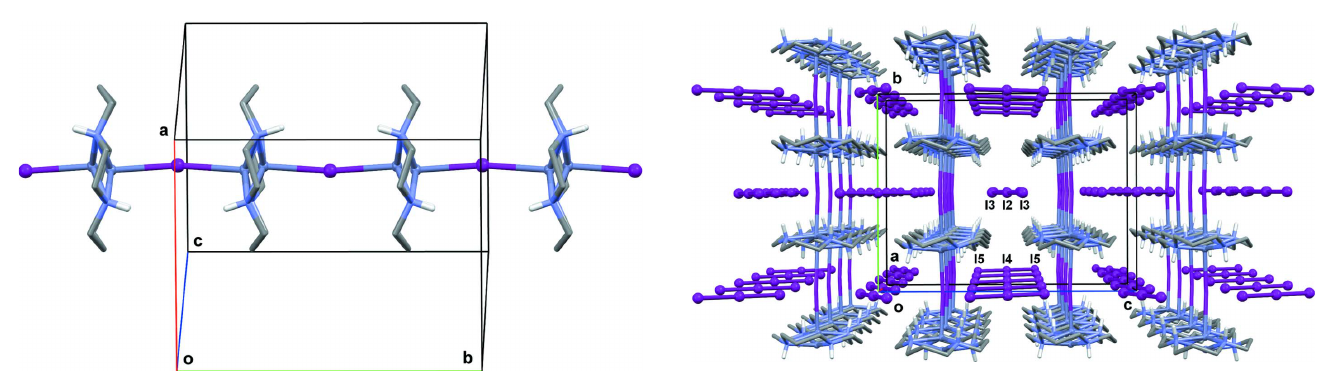
Figure 6 The arrangement of [Zn( L )I] + cations along the b -axis direction in II . C- bound H atoms are omitted for